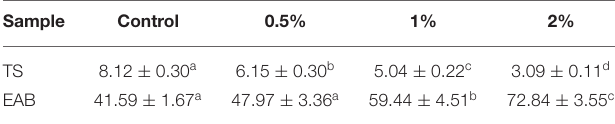
TABLE 2 | Tensile strength and elongation at break of cassava starch-based films incorporated with geranium essential oil (GEO).